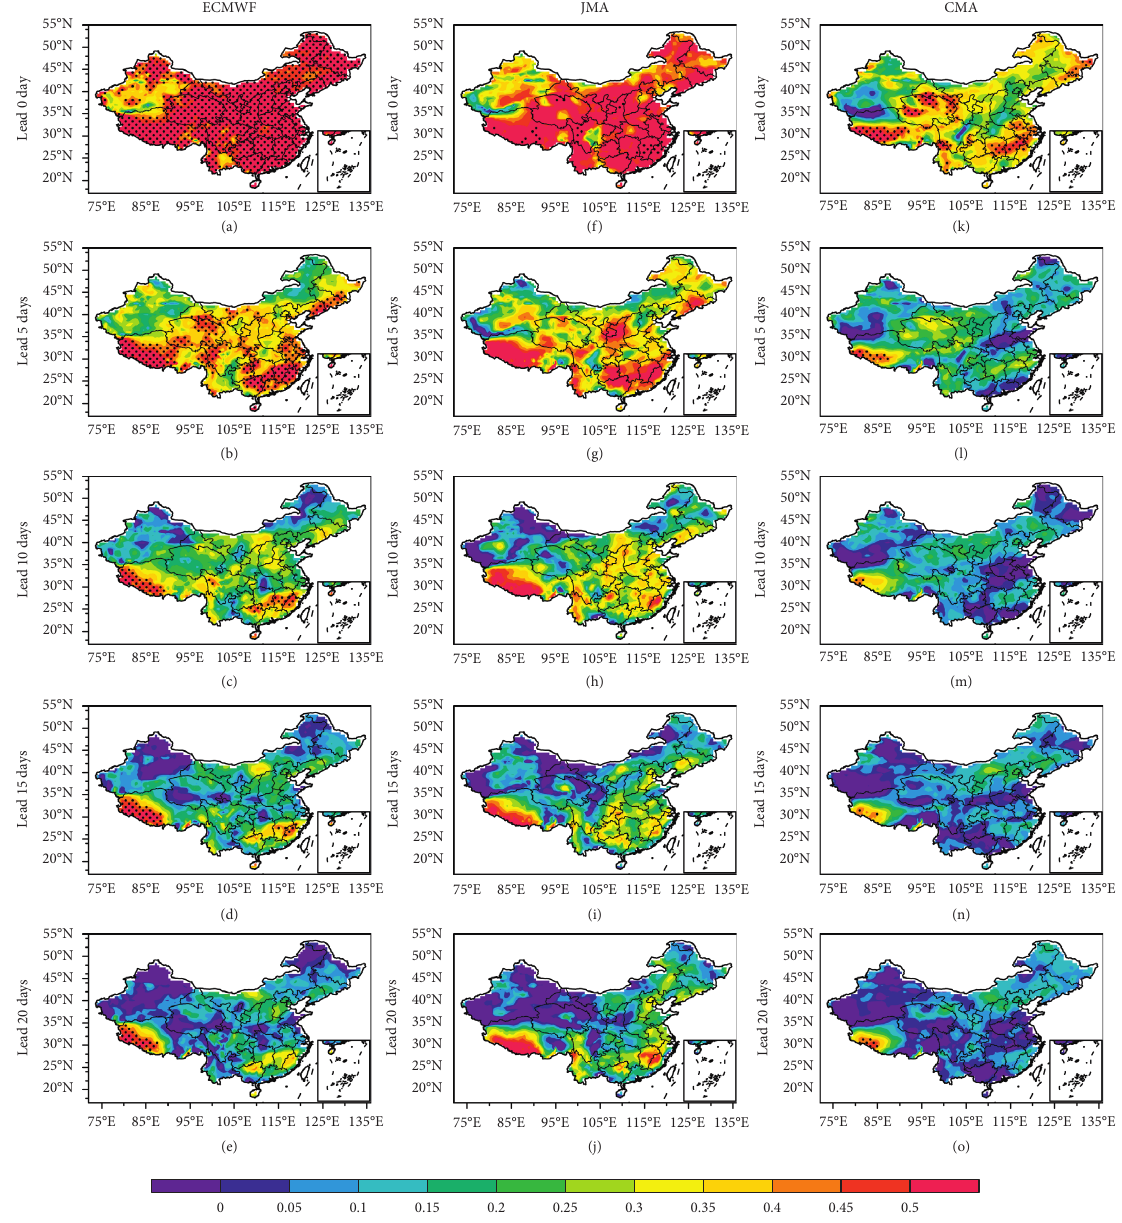
Figure 1: The multiyear average (1995–2010) of the TCC between the ensemble mean and observed summer accumulated ten-day precipitation for ECMWF (a–e), JMA (f–j), and CMA (k–o) S2S hindcast experiments at the lead times of 0, 5, 10, 15, and 20 days in China. The dots represent TCC exceeding 95% confidence level. The lower right part of the figure is an administrative zoning map of the South China